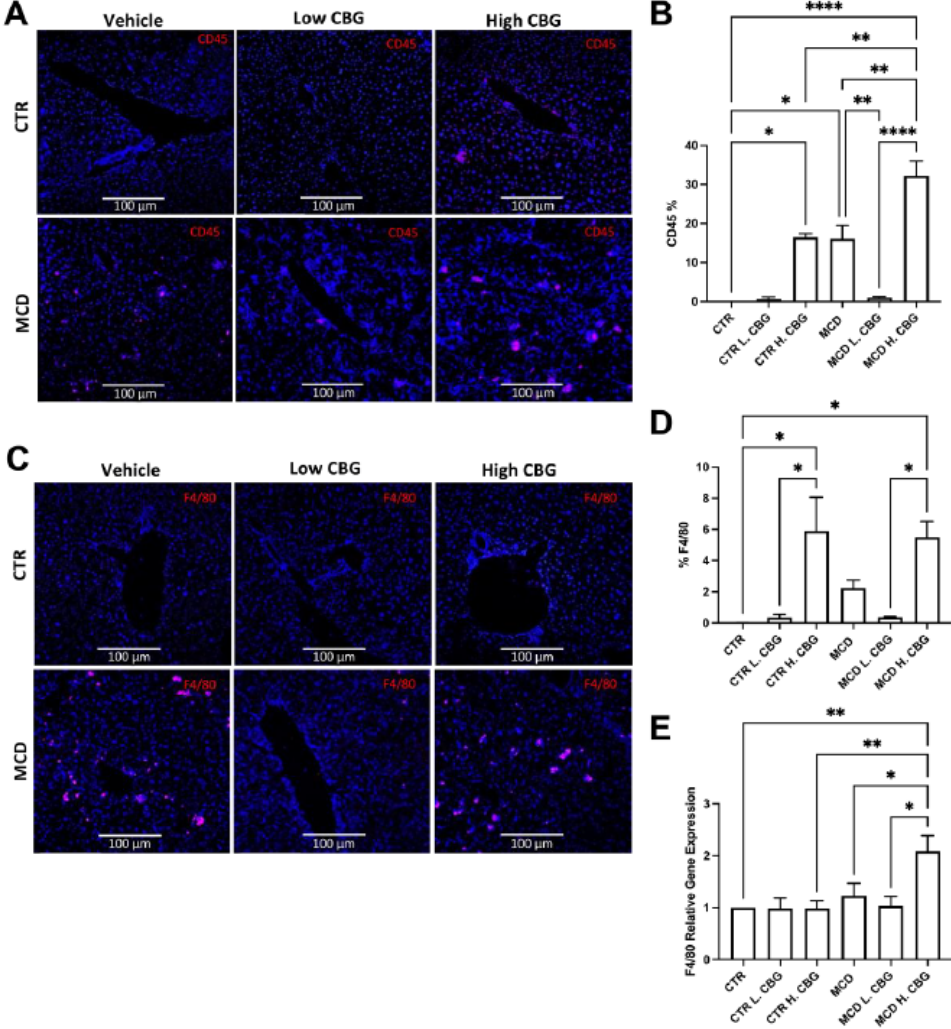
Figure 3. Immunofluorescence staining and RT-qPCR were utilized to measure inflammation in liver tissues. Representative image of liver frozen sections stained for white blood cells showing CD45 in red and DAPI in blue ( A , 20 × ), which was quantified using ImageJ ( B ). The infiltration of macrophages (F4/80 + ) were shown in red, while nuclei were shown in blue by DAPI staining ( C ). Images of F4/80 was also quantified using ImageJ ( D ). Quantification of mRNA